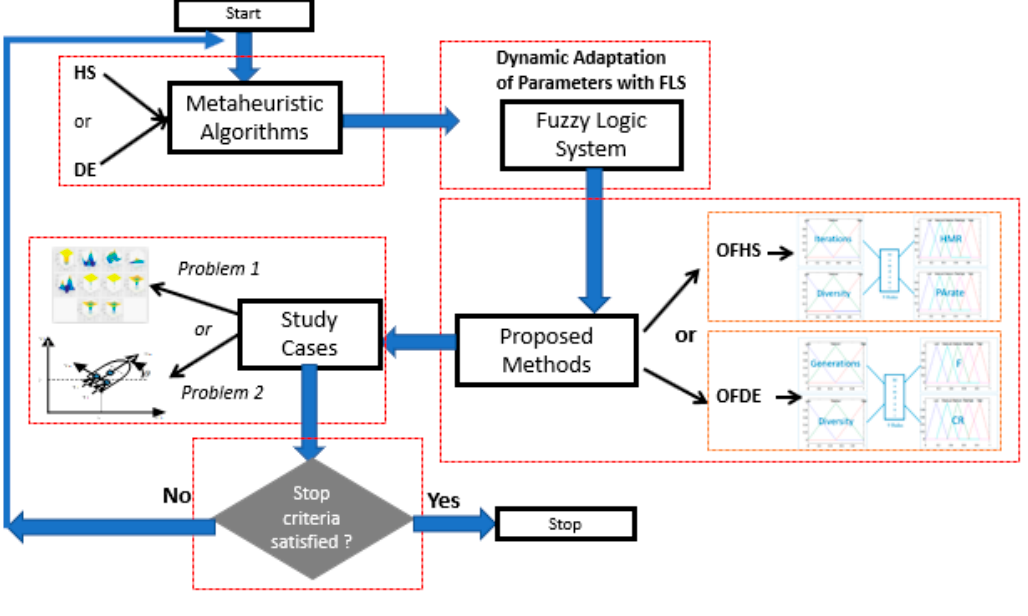
Figure 1. Proposed method.